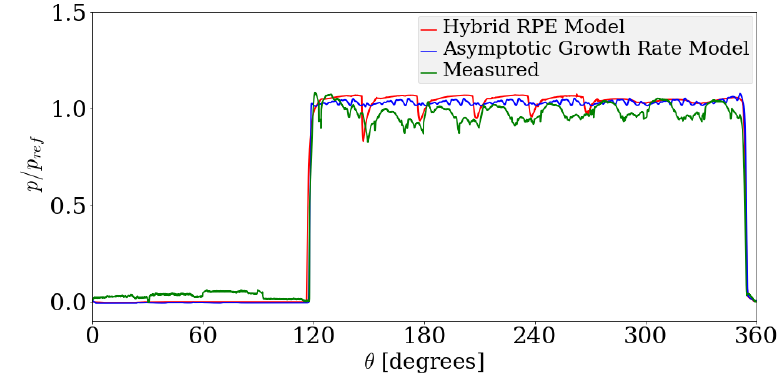
Figure 17. Comparison between instantaneous TSV pressure profiles for the Asymptotic Growth Rate model, Hybrid Rayleigh–Plesset solution approach with experimental data for 1500 rpm speed and suction pressure of − 0.64 bar gauge pressure.